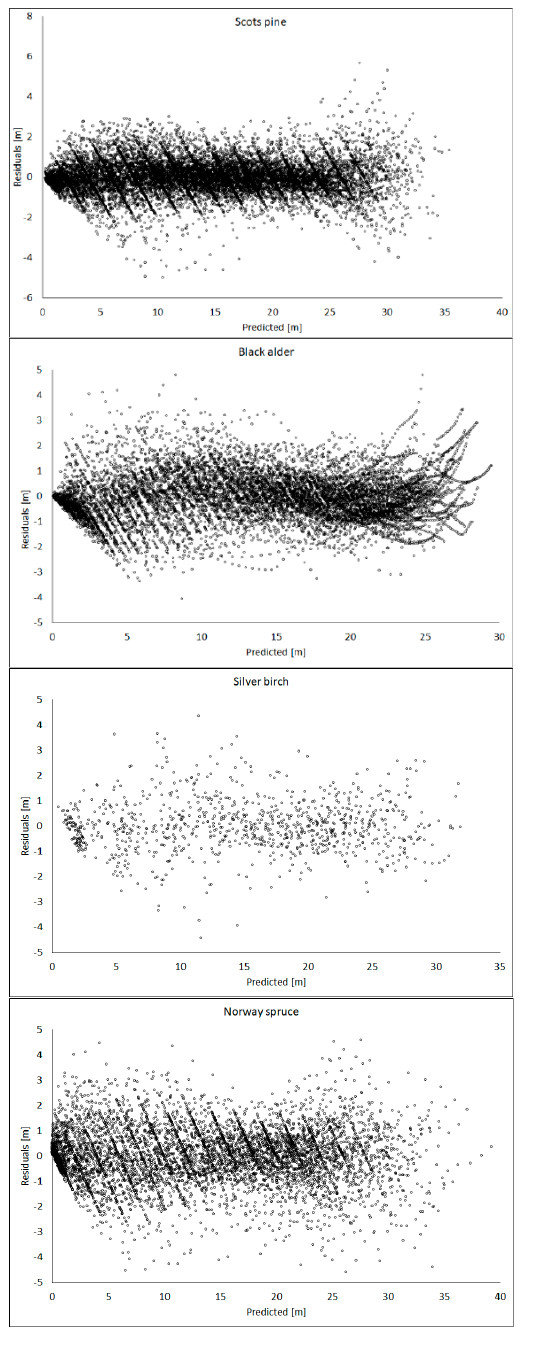
Figure 3. Residual versus predicted values from the selected site index models for the analyzed tree species studied.